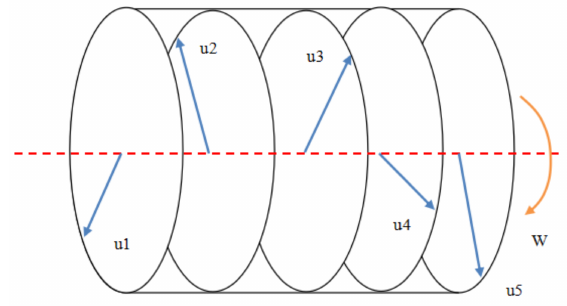
Figure 4. Five-stage disc rotor assembly